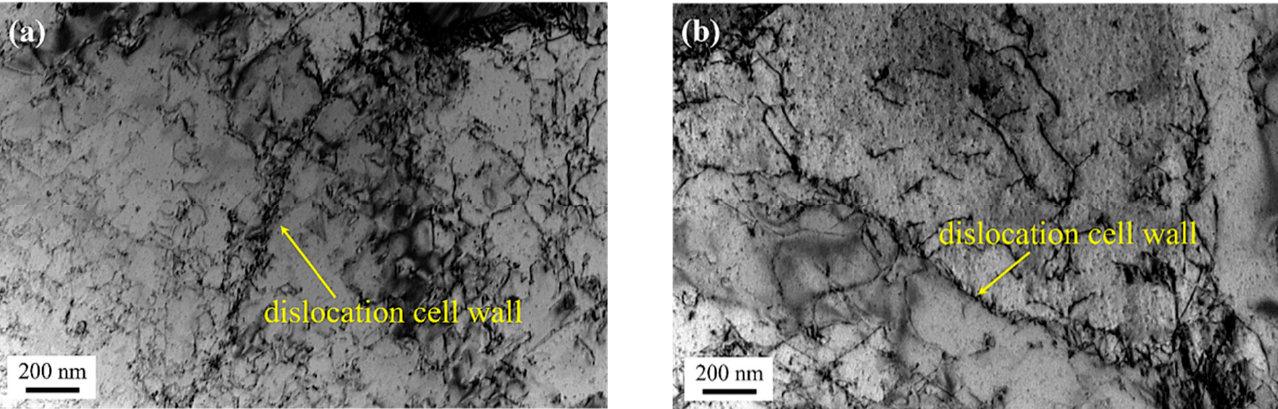
Figure 5. ( a , b ) Representative bright-field TEM micrographs of the center part of a SMAT processed SS 316L specimen.